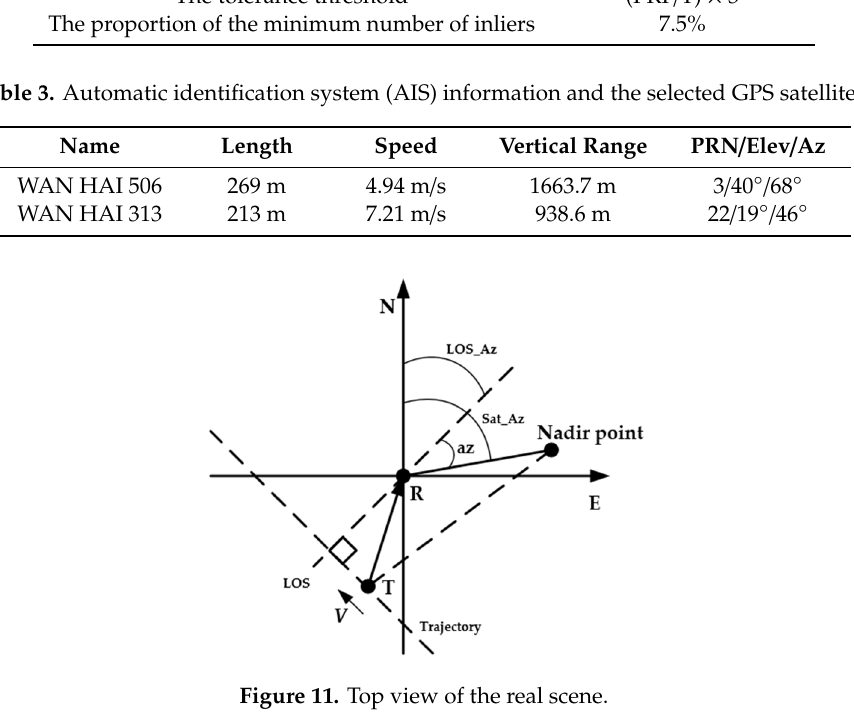
( b ) Figure 12. Photographs of two cargo ships: ( a ) is WAN HAI 506 at 16:26, and ( b ) is WAN HAI 313 with a yacht at 16:40. 4.2. Velocity Estimation Results and SAR Images Figure 13 shows the fitting results of two cargo ships via RANSAC, LSM, and the ground truth from AIS. In Figure 13a, we can find that the number of noise points seem to be more than that of the target points. However, RANSAC can still provide a good fitting line (red line) compared with the ground truth (black line), which implies that the estimated velocity is close to the AIS velocity. However, LSM shows a fitting line (green dashed line) with a positive slope value. As described in (22), the chirp rate is always negative. Therefore, LSM has failed to be applied in the velocity estimation. In Figure 13b, there is a small angle between the red line and the black line. The main reason is that the fluctuations of the target complex reflectivity influence the distribution of the sampling points. Particularly, the echoes whose Doppler frequencies are near zero have the strongest scattering effect shown in Figure 8b, resulting in more sampling points than that from other Doppler